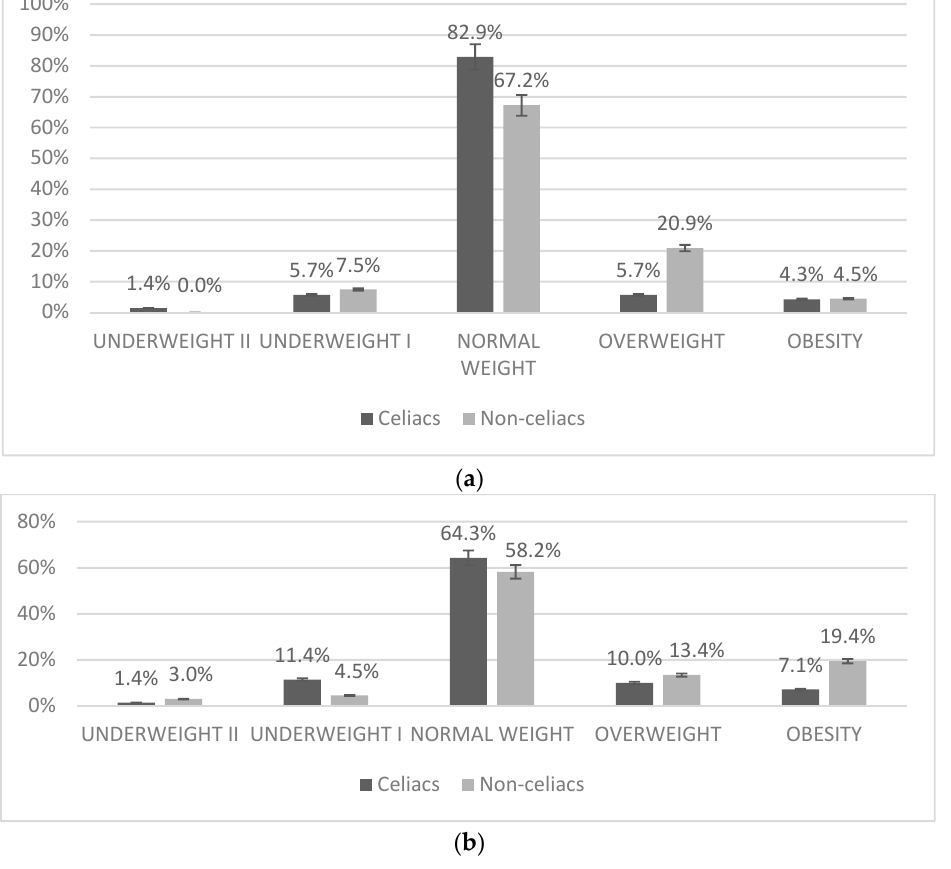
Figure 1. Classification of study participants according to BMI. ( a ) Classification according to BMI as proposed by Orbegozo [32] ( b ) Classification according to BMI as proposed by WHO [31]. Results are expressed as frequency (%) of the total study group.